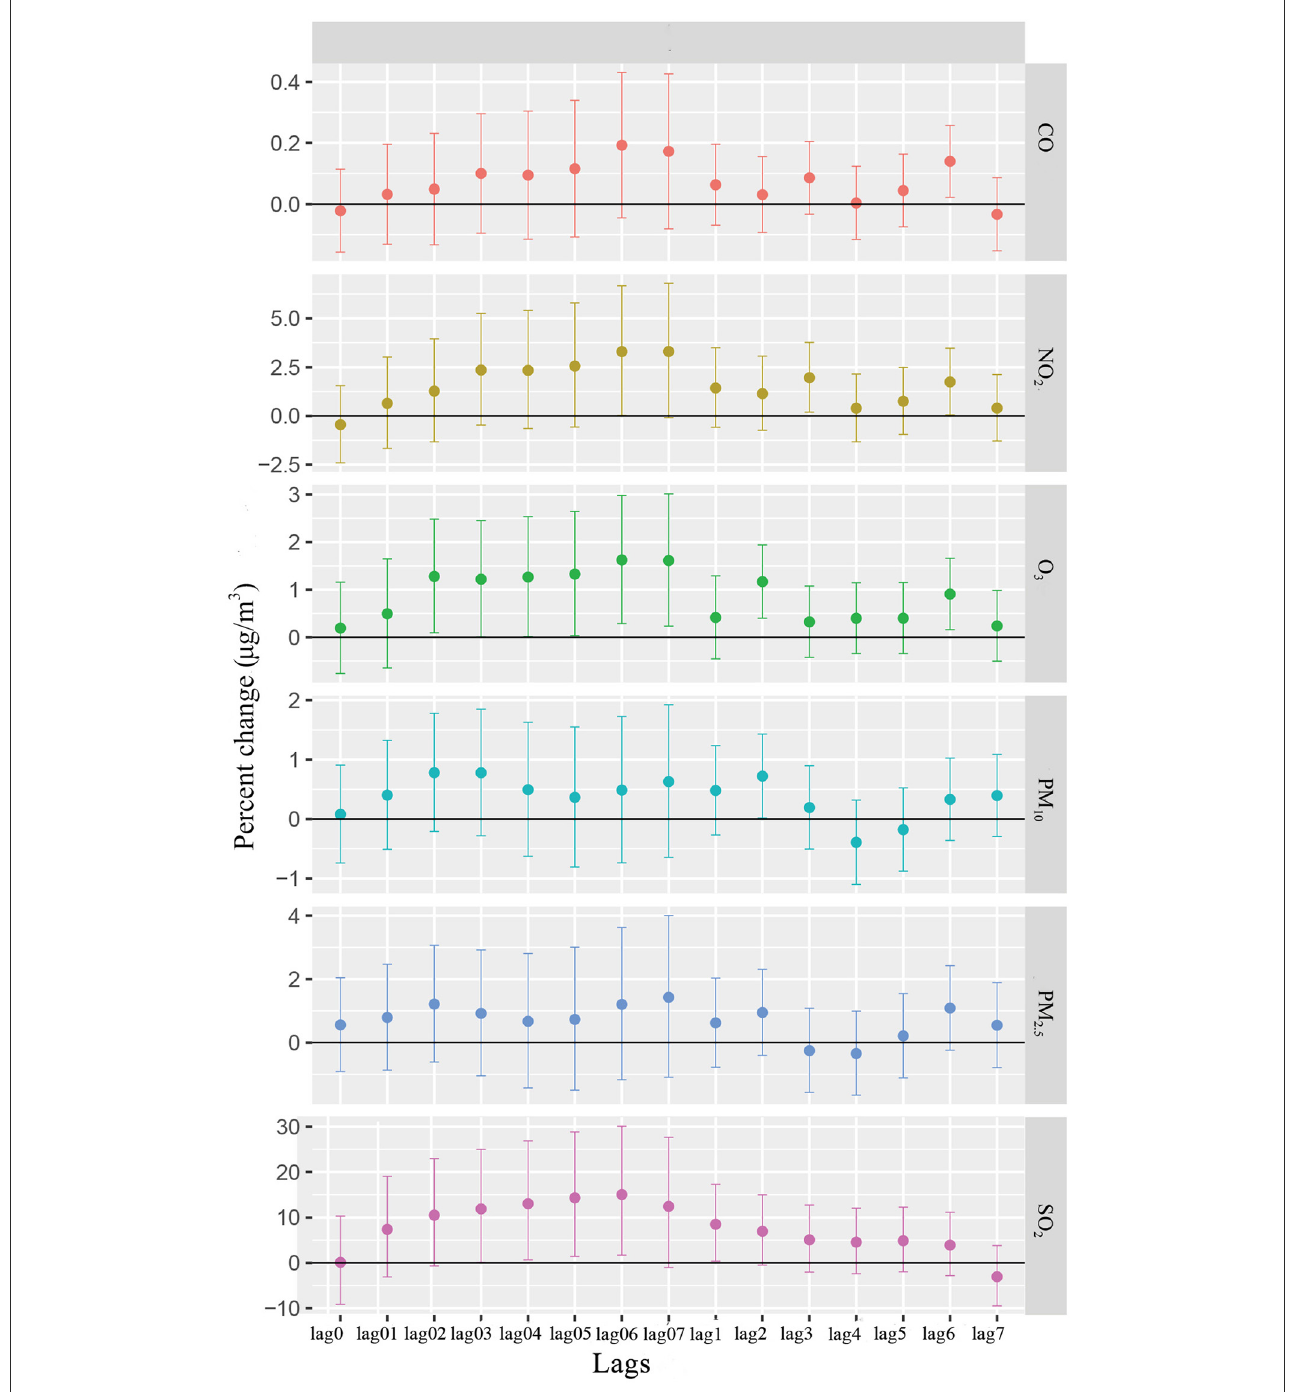
FIGURE4 Percentage change (%) of EDVs for urolithiasis (mean and 95%CI) associated with a 10 µ g/m 3 increase in various air pollutant concentrations using different lag structures.